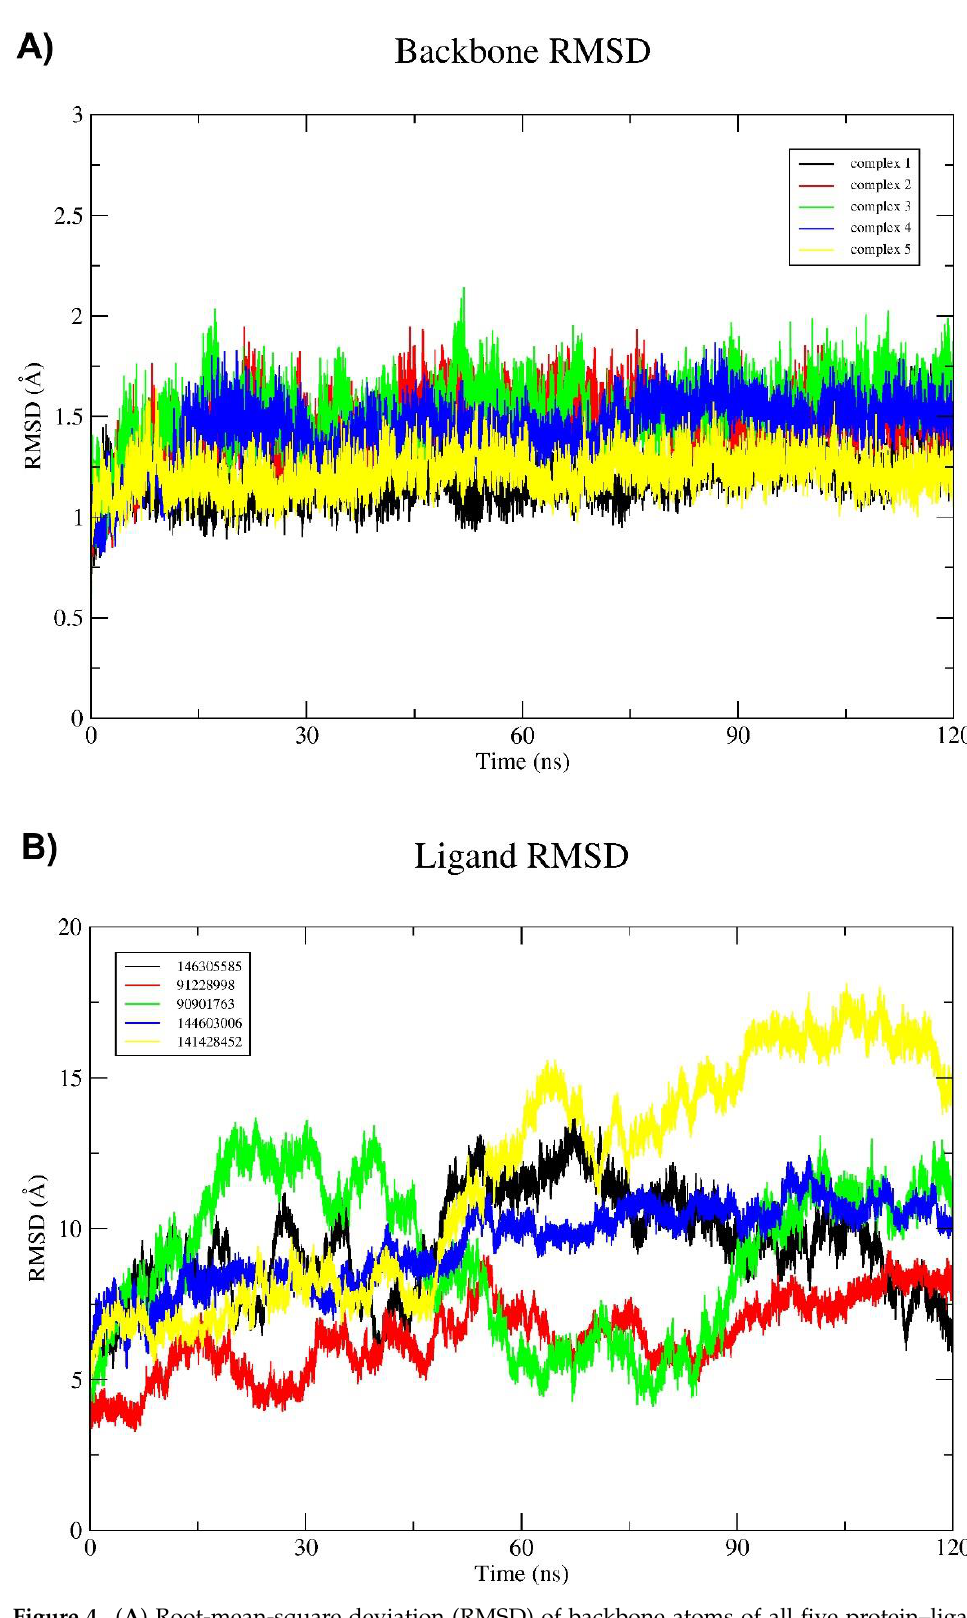
Figure 4. ( A ) Root-mean-square deviation (RMSD) of backbone atoms of all five protein–ligand Figure 4. A) Root-mean-square deviation (RMSD) of backbone atoms of all five protein – ligand com- complexes and ( B ) Ligand RMSD of all five potential inhibitor molecules through plexes and B) Ligand RMSD of all five potential inhibitor molecules through time.